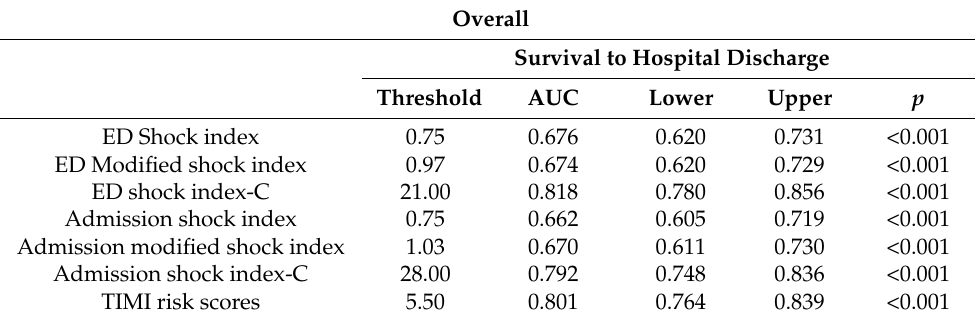
Table 3. Receiver operating characteristic (ROC) curve analysis of the optimal thresholds of the SI, MSI, SIC, and TIMI risk scores for predicting in-hospital